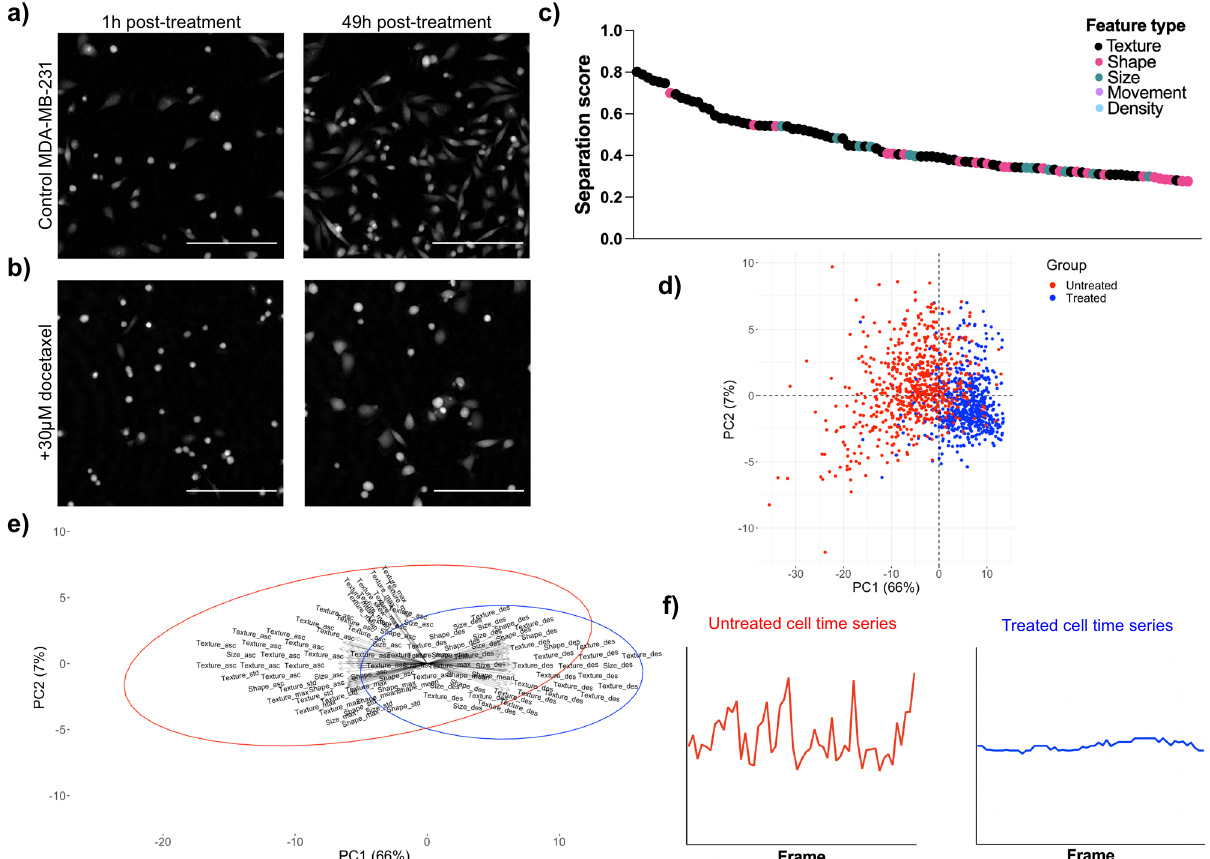
Fig. 3 | Discrimination between treated and untreated cells for MDA-MB-231 with docetaxel. Images taken from cell time-lapses of a untreated MDA-MB-231 cells and b 30 μ M docetaxel treated MDA-MB-231 cells. Scale bar=200 μ